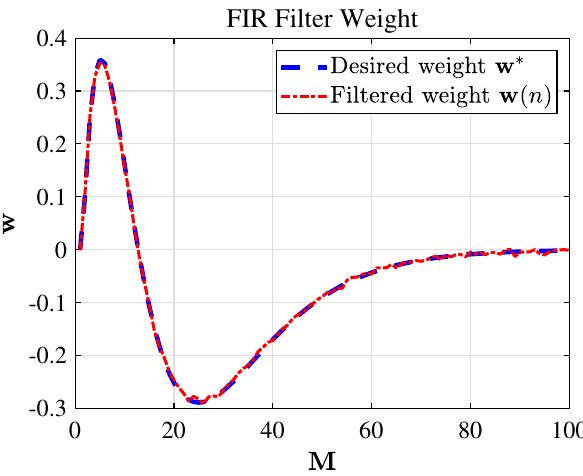
Figure 4. FIR filter weight of FDSAF-MCC under non-Gaussian noise.